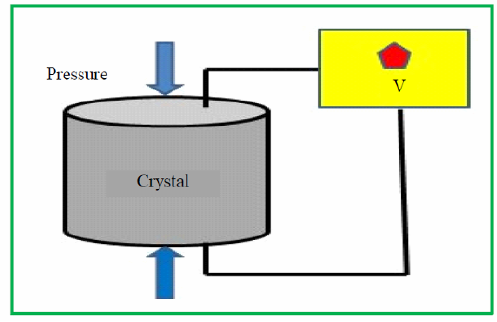
Fig. 6 Set-up of piezoelectric based pressure sensor. Table 1 Characteristics of piezo sensor materials vs. other types [11].